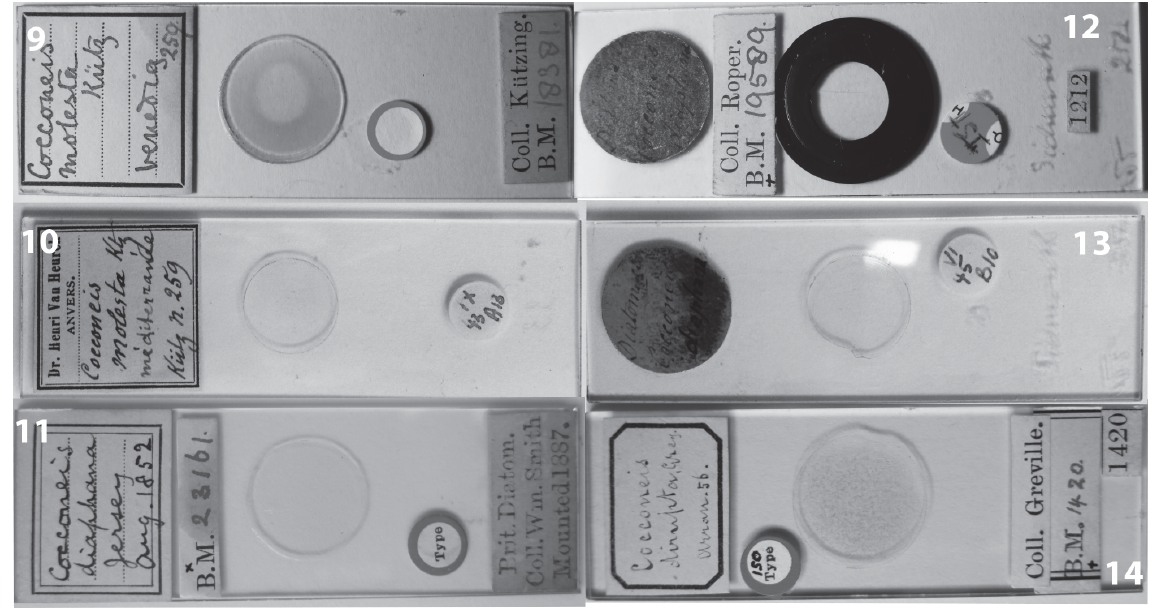
Figs 9–14. Illustration of the type slides. 9 . Cocconeis molesta Kütz.: F.T. Kützing collection, no.